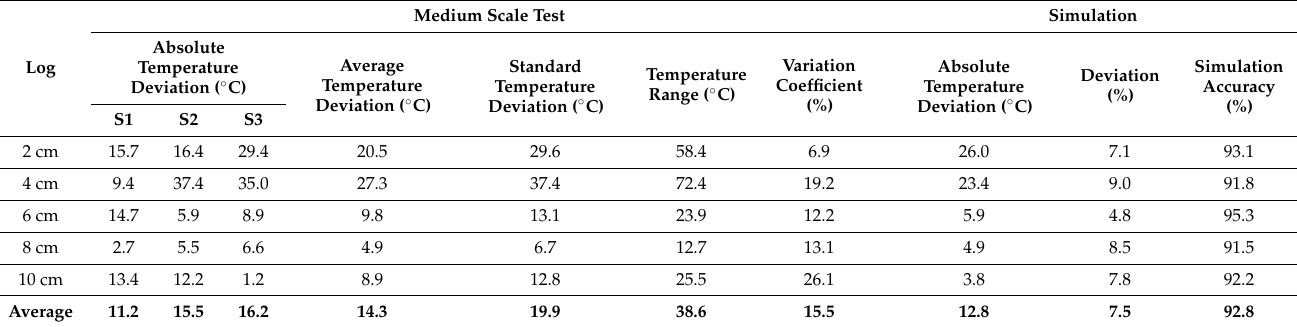
Table 2. Statistical indicators—Norway spruce